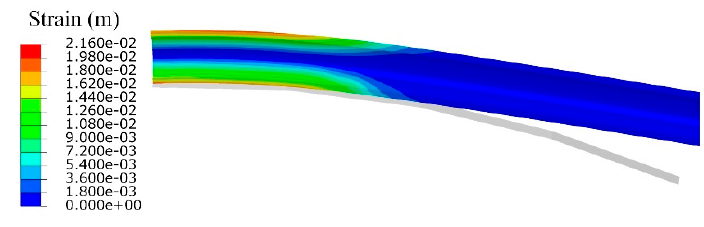
Figure 10. The strain distribution of the pipe during reeling.